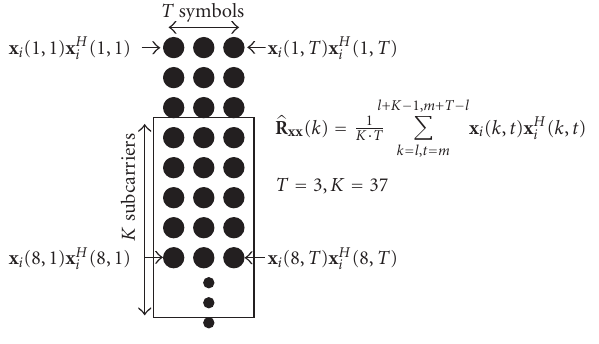
Figure 4: Moving average